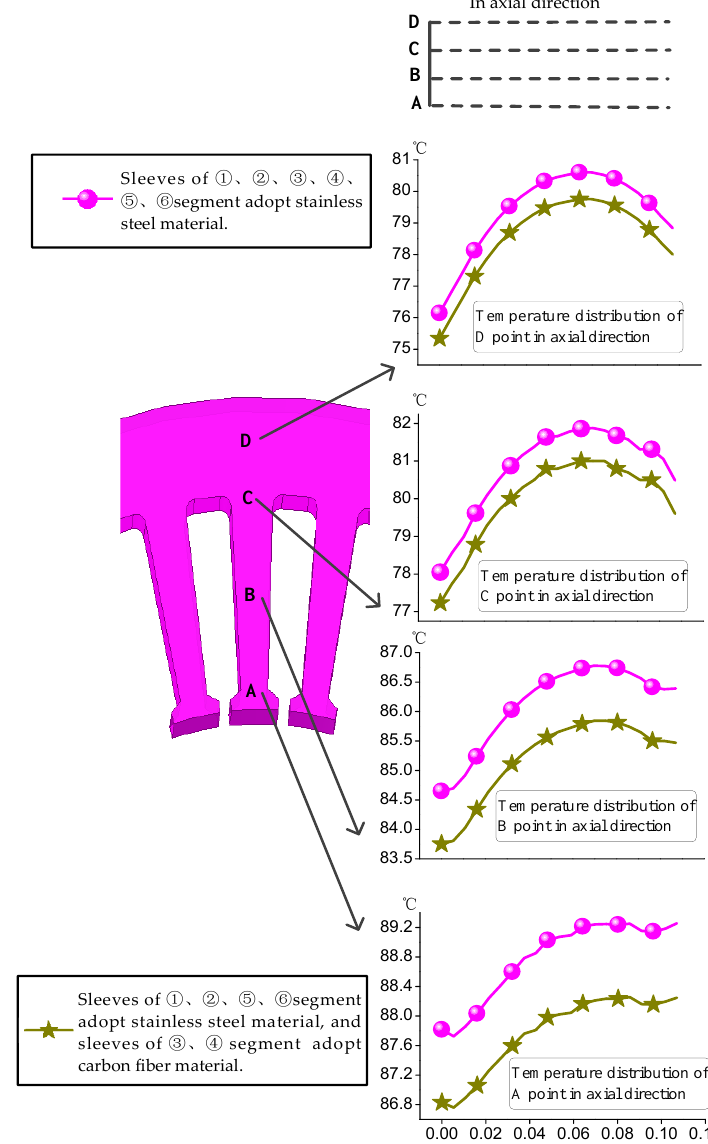
Figure 7. Temperature distribution of tooth center line in axial direction before and after the proposed method suppressing permanent magnet local maximum